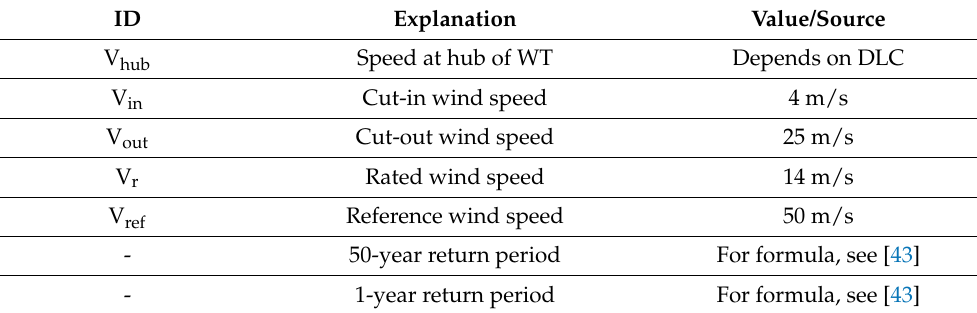
Table 4. Relevant wind speeds specified using the IEC 61400-1 [38] and Vestas V52 datasheet